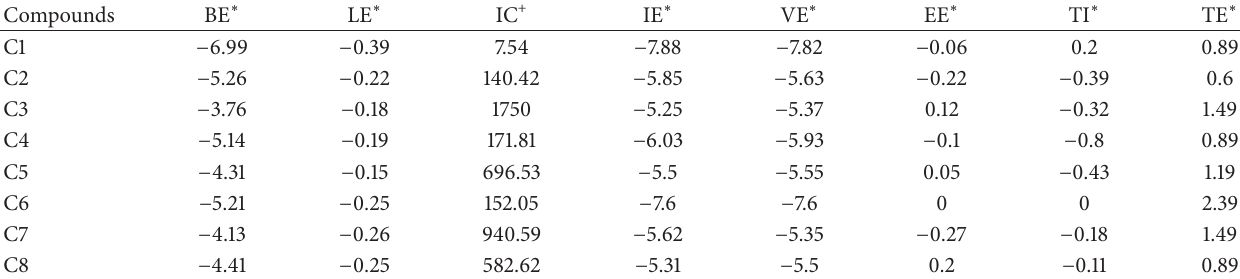
Table 2: Molecular docking interaction details of benzofuran and naphthofuran derivatives against NarL protein.